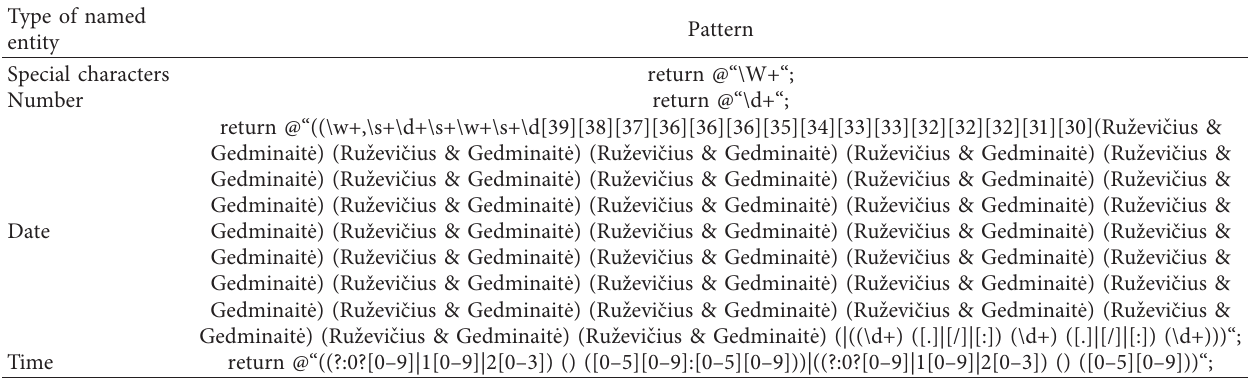
Table 9: Example of patterns.